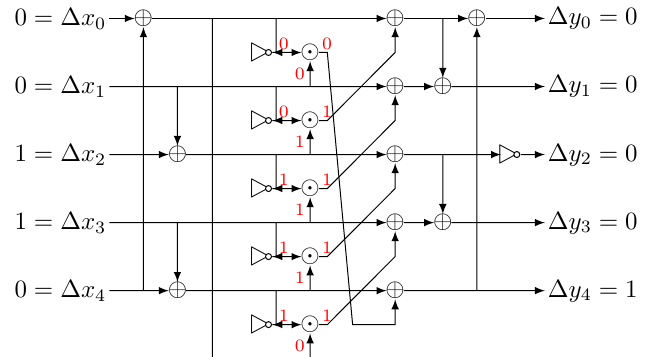
Figure 2: Ascon Sbox with the propagation of ∆ in = 0x6 and ∆ out =